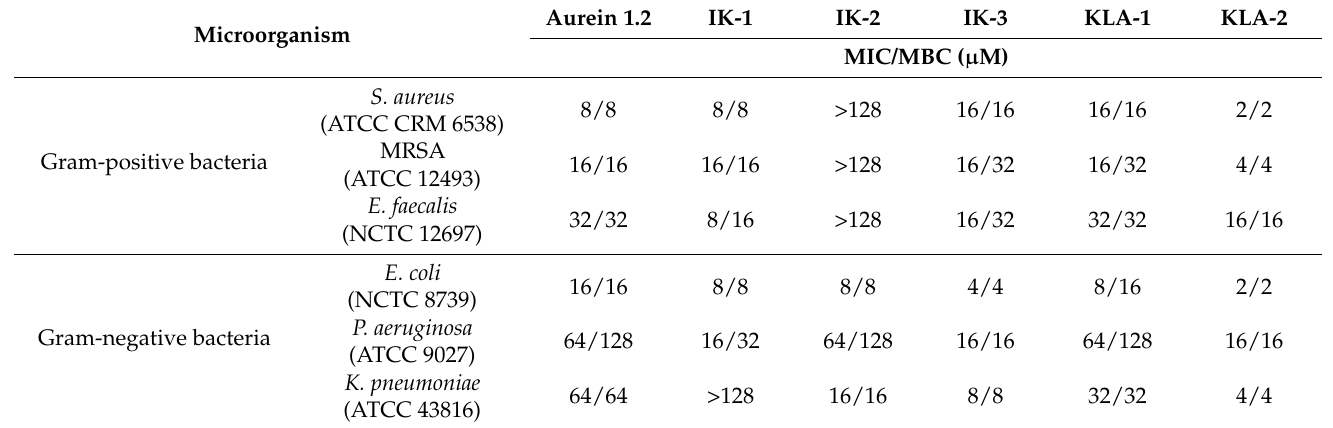
Table 2. The MIC and MBC values of aurein 1.2 and its analogues.